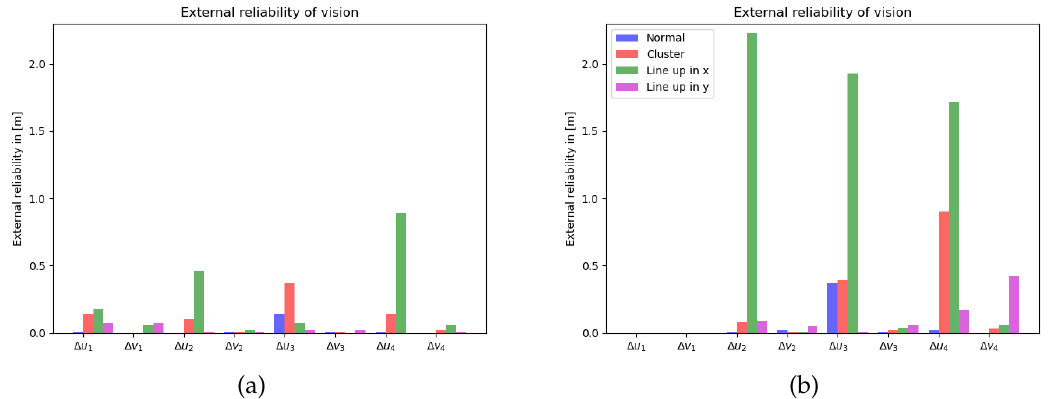
Figure 6. External reliability: magnitude of bias vector in horizontal position, by undetected outlier in vision measurements, computed for 4 features ( a -left), and 3 features ( b